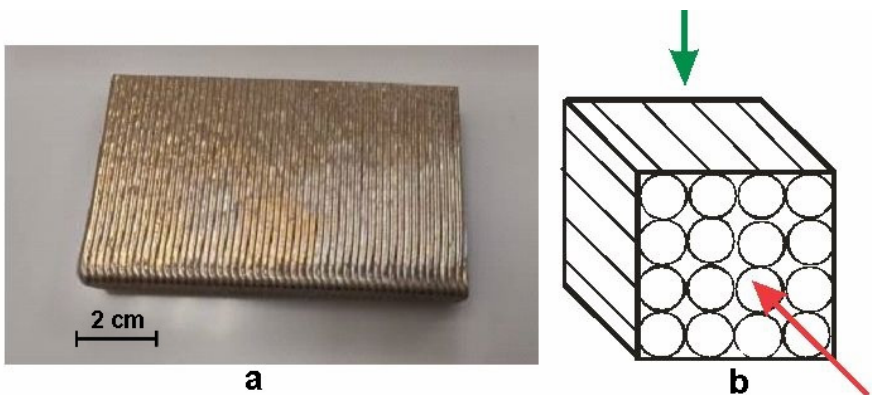
Figure 1. The appearance of the Inconel 718 alloy workpiece obtained by direct laser deposition ( a ) and the scheme of shockwave loading of additively manufactured samples relative to the direction of deposition ( b ). Red arrow—loading along the direction of the deposition, green—perpendicular.